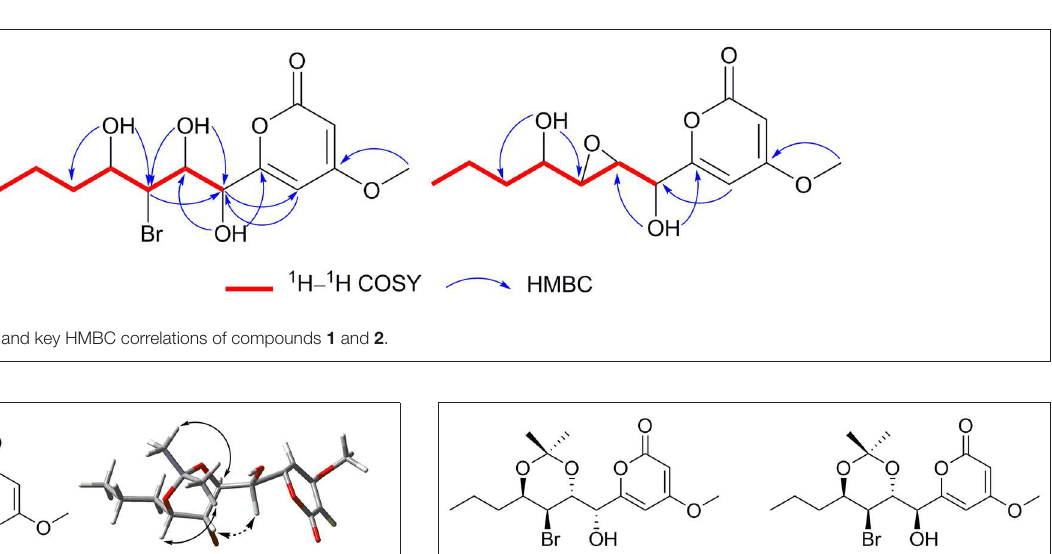
FIGURE 2 | The chemical structures of compounds 1 – 6 .